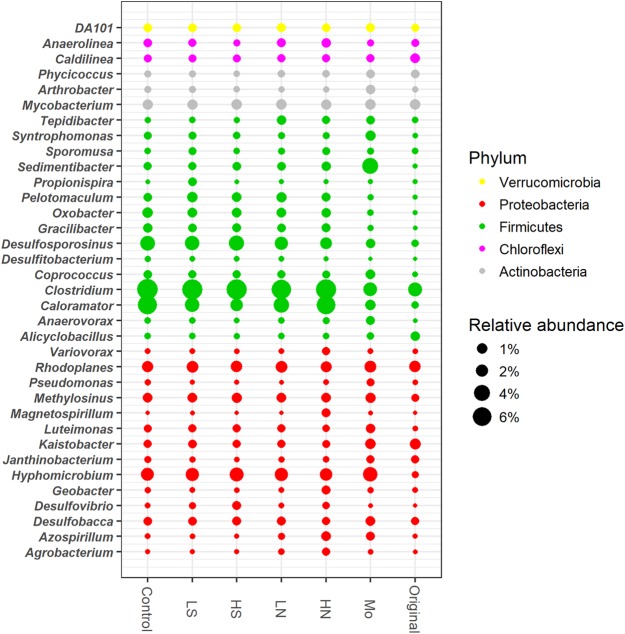
Dominant bacterial genera in all treatments. Original, soil sample was on day 0. Other treatments, samples were on day 40. The meanings of the abbreviations in the graph are the same as in Figure 3.